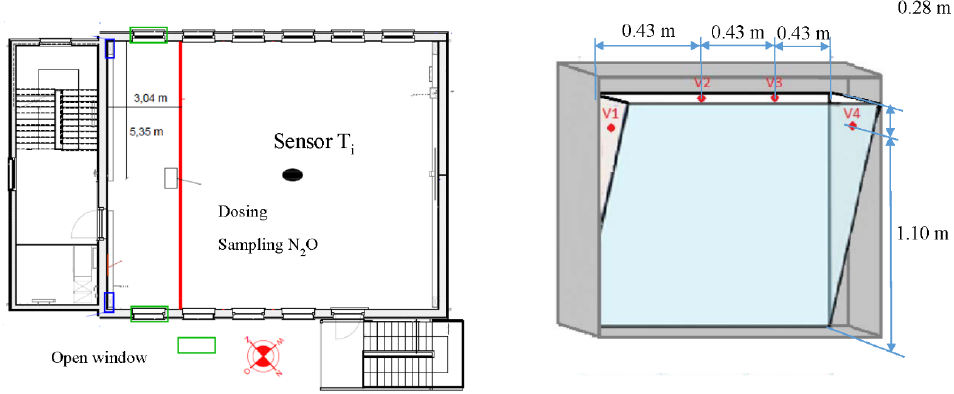
Figure 6. Test setup tracer gas measurement ( left ) and air velocity measurement (position of the sensors) ( right ).